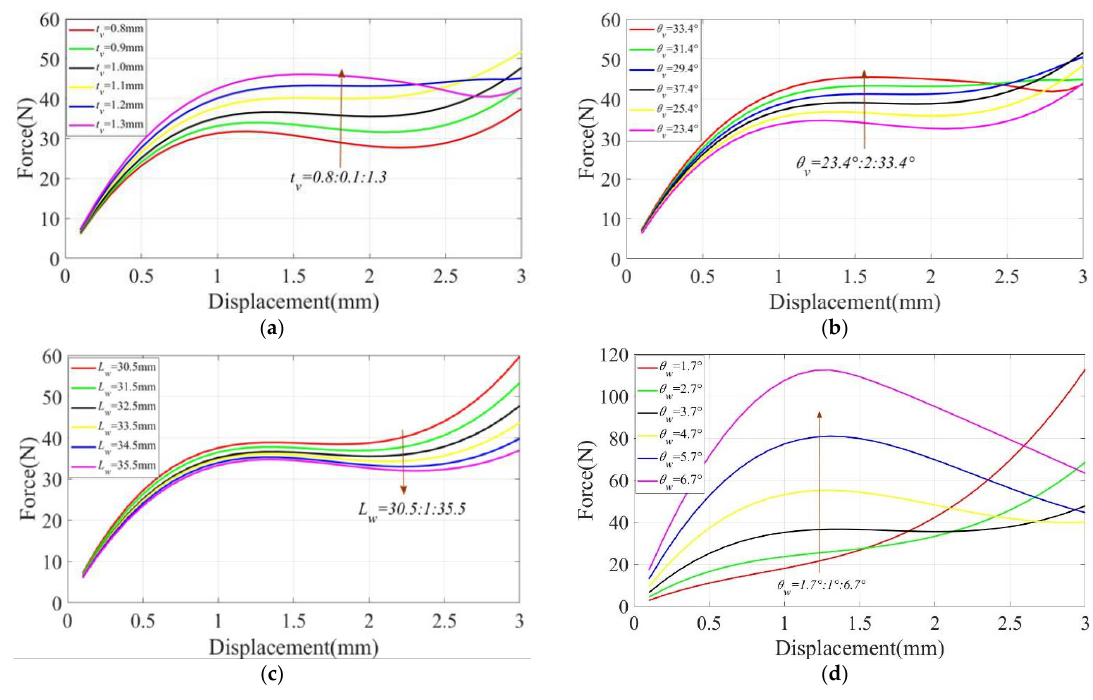
Figure 10. Institutional parameters: ( a ) 𝑡 𝑣 ; ( b ) 𝜃 𝑣 ; ( c ) 𝐿 𝑤 ; ( d ) 𝜃 𝑤 .